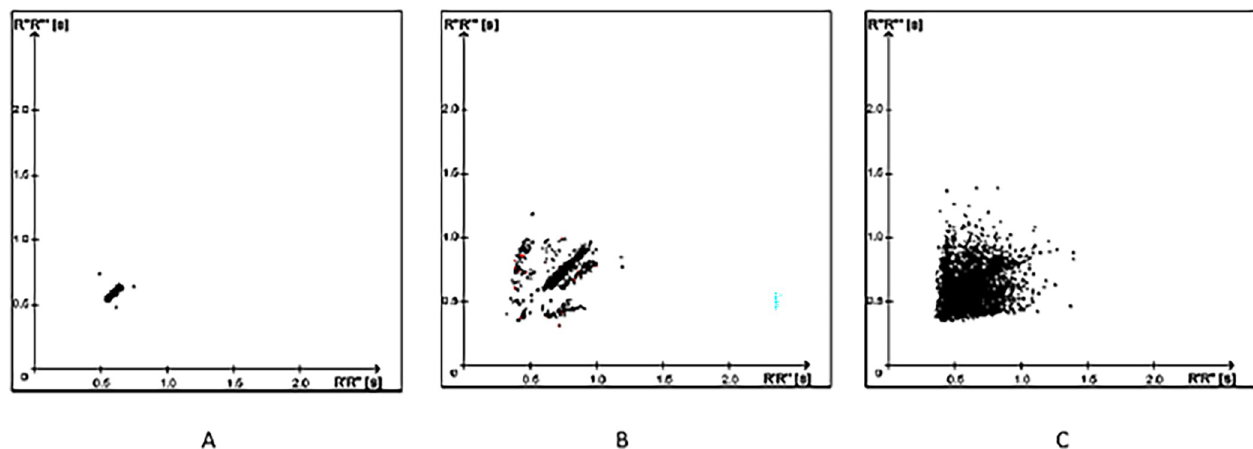
Fig 1. Poincare´ plots based on RR intervals on Holter tracings. On the abscissa are the values of the preceding RR intervals and on the ordinate are the current RR intervals. The shape of the distribution of points on the graph visually defines the three conditions in which the patient may be. In A, clustered points or on a stick or golf club indicate that the patient is in sinus rhythm; in B, scattered points along the rod indicate a patient at risk of atrial fibrillation; in C, the full dispersion of points indicated that the patient is in atrial fibrillation (see discussion in